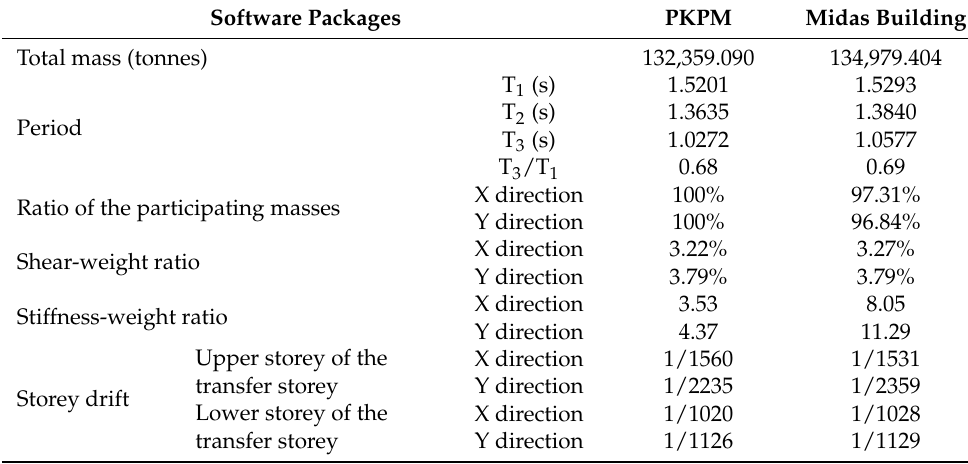
Table 6. Results of the response spectrum